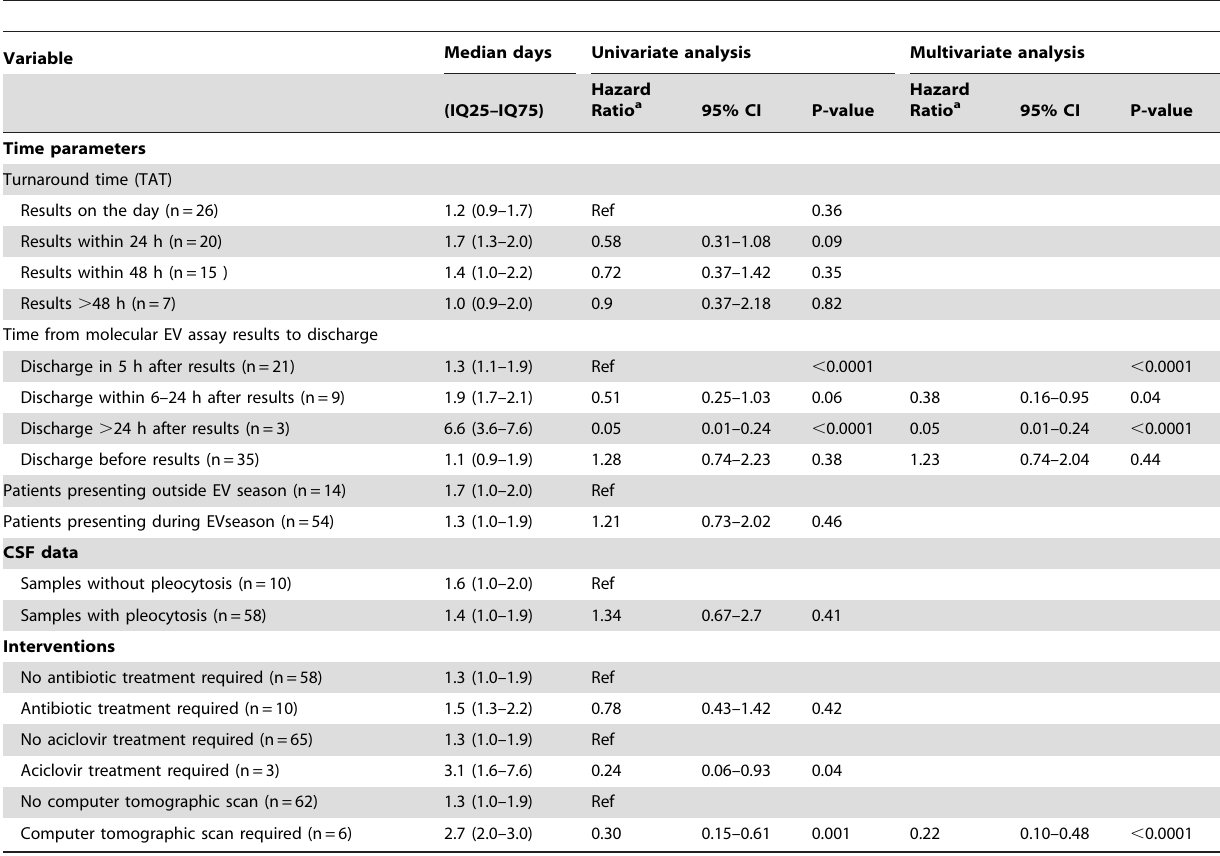
Table 2. Univariate and multivariate analysis of factors associated with hospital length of stay in children (n =68) with enterovirus (EV) meningitis during the two study periods